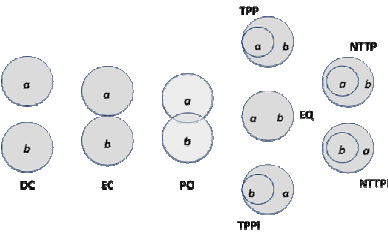
Figure 2. RCC8 Topological Model